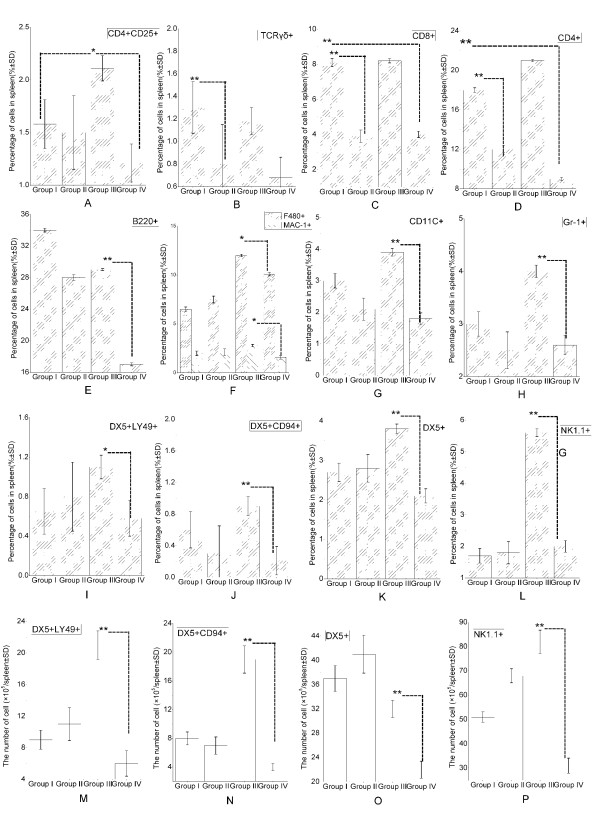
Analysis of splenic cell populations in L. monocytogenes infection. The populations of the NK cell subsets are indicated for the four groups; Group I, non-infected Se-adequate; Group II, non-infected Se-deficient; Group III, infected Se-adequate; and Group IV, infected Se-deficient. Cell surface expression of the indicated markers was determined for splenic lymphocytes from above four groups of mice on hour 72 of L. monocytogenes infection. Data are shown as percentage of positive cells in the spleen for each marker. Data are plotted as mean ± SD of analysis (50,000 events per sample) done on individual mouse spleen (N = 5 for each group). Statistical comparisons done between Se-adequate and Se-deficient groups indicated significant reduction in the expression of CD4 and CD8 under the conditions of Se deficiency. Statistical analysis done between Se-adequate and infected Se-adequate mice groups indicated significant increase in the expression of NK1.1 and DX5 post infection. Statistical analysis done between infected Se-adequate and infected Se-deficient mice groups indicated significant reductions in CD4+CD25+(A), TCRγδ+(B), CD8+(C), CD4+(D), B220+(E), F480+ and MAC-1+(F), CD11c+(G), Gr-1+(H), DX5+Ly49D+(I), DX5+CD94+(J), DX5+(K), and NK1.1+(L) populations under the conditions of Se deficiency. The percentages of DX5+Ly49D+(M), DX5+CD94+(N), DX5+(O), and NK1.1+(P) cells obtained after analysis of individual spleen samples were converted into numbers of each cell population based on the total splenocyte count obtained for each mouse. Results are expressed as the mean cell count per group ± standard deviation (SD). *p < 0.05, **p < 0.01.